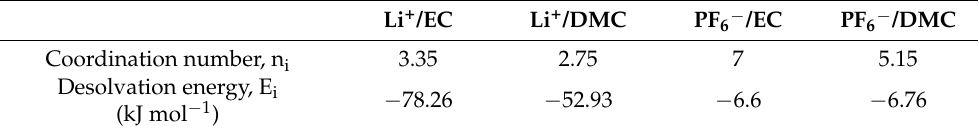
Table 1. Parameters of the electrolyte ions in different solvents as determined from molecular